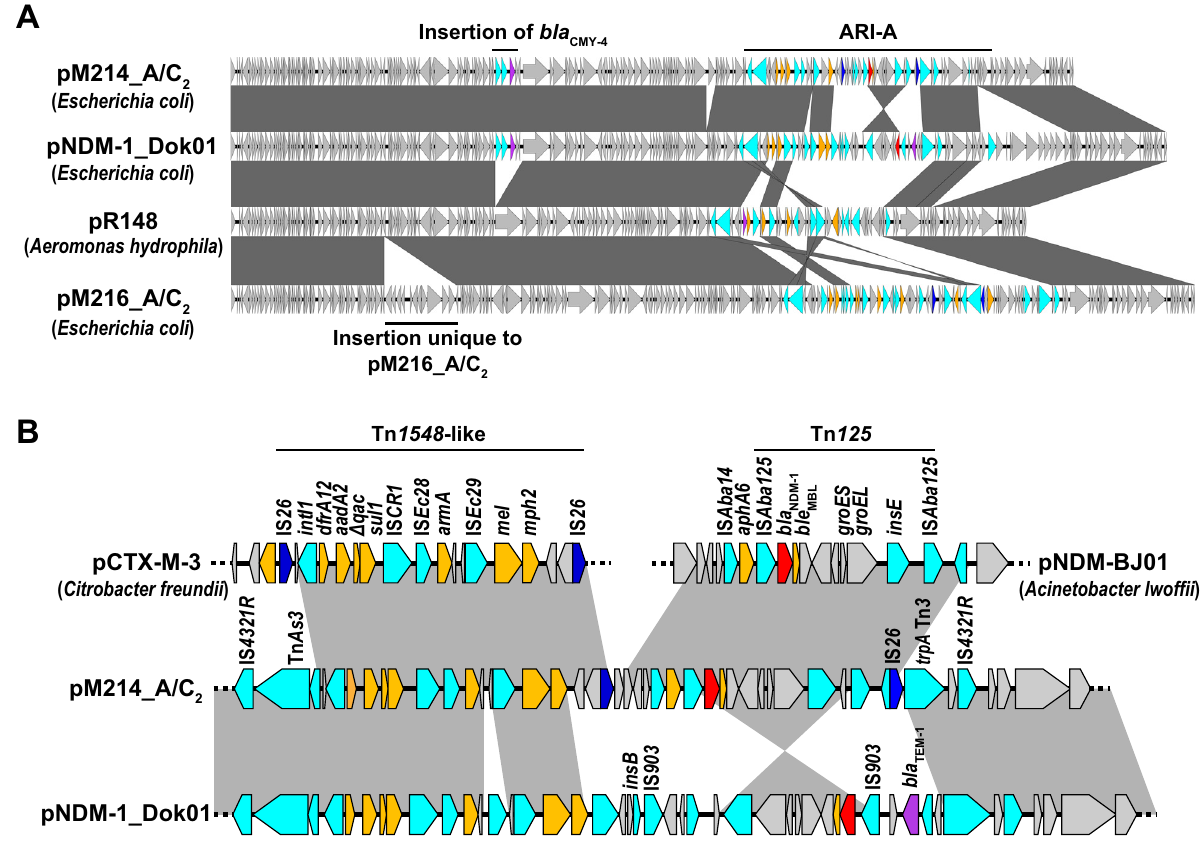
Fig 2. IncA/C 2 plasmids harboring bla NDM-1 . (A) Comparisonof IncA/C 2 plasmidsisolatedin this study with similar and/or putative backboneplasmidspNDM-1_Dok01 and pR148. Homologousregions are shadeddark gray. Genes are indicatedin colors as follows: bla NDM-1 , red; other β -lactamases, purple; other antimicrobial-resistancegenes, orange; IS 26 , blue; other mobile geneticelements, cyan; other accessory genes, light gray. The origins of the indicatedplasmidsare shown in parentheses. pM214_A/C 2 and pNDM-1_Dok01 harbor the class C β -lactamase gene, bla CMY-4 . (B) Schematic representation of the geneticcontext of bla NDM-1 in pM214_ A/C 2 and in other